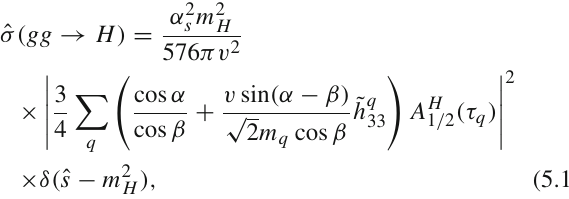
The SM expectations are R D = 0 . 300 ± 0 . 008 and R D ∗ = 0 . 252 ± 0 . 003 [52], but the experimental results for R are deviated from the SM values by more than 2 σ